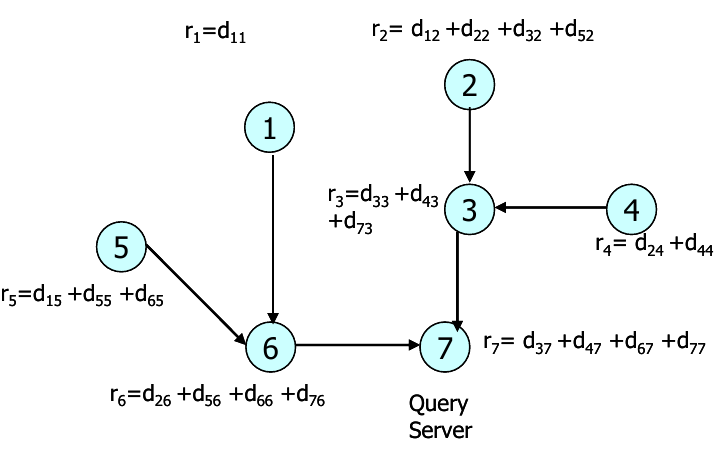
Figure 6. Data slices in